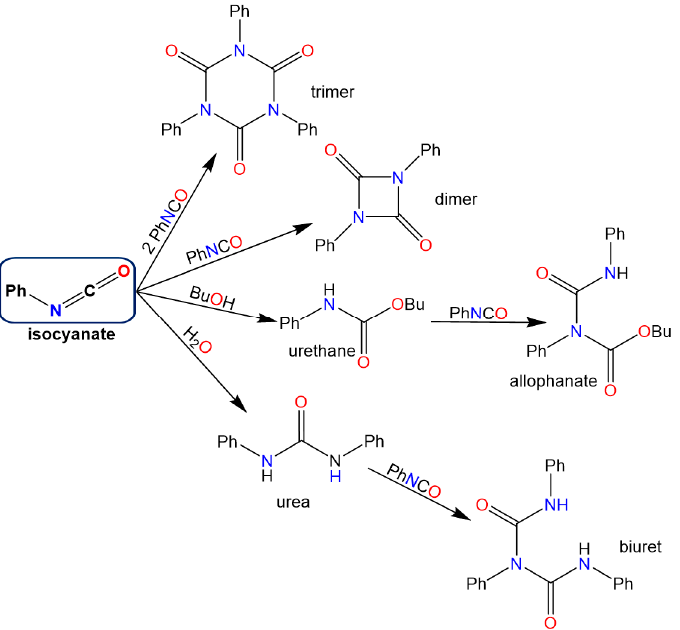
Figure 2. Possible products of the phenyl isocyanate (PhNCO)/butan-1-ol (BuOH) reaction system. Low residual water content giving rise to urea formation originates from the solvent.